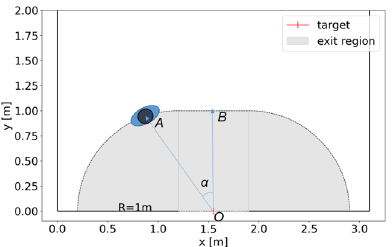
Figure 3. Definition of exit region and incident angle in pre-school children’s experiment. The exit region consists of a rectangle and two 1/4 circles (grey regions). The angle α between the vector represents the incident angle of pedestrians. The angle between represents the entering exit region position of the pedestrian.